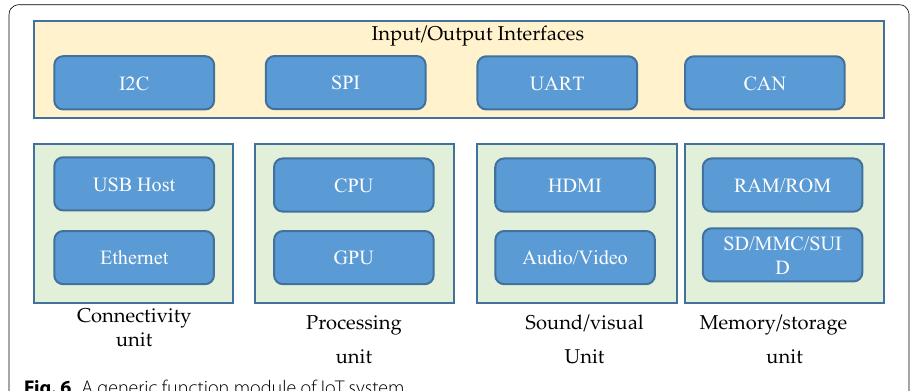
Fig. 6 A generic function module of IoT